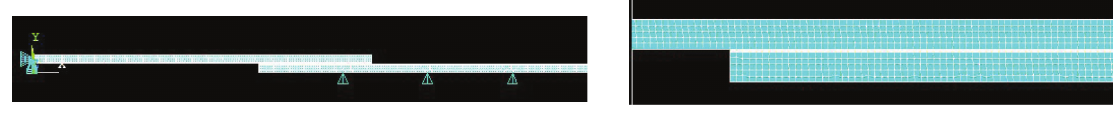
Figure 5 Mesh model of the stress singularity